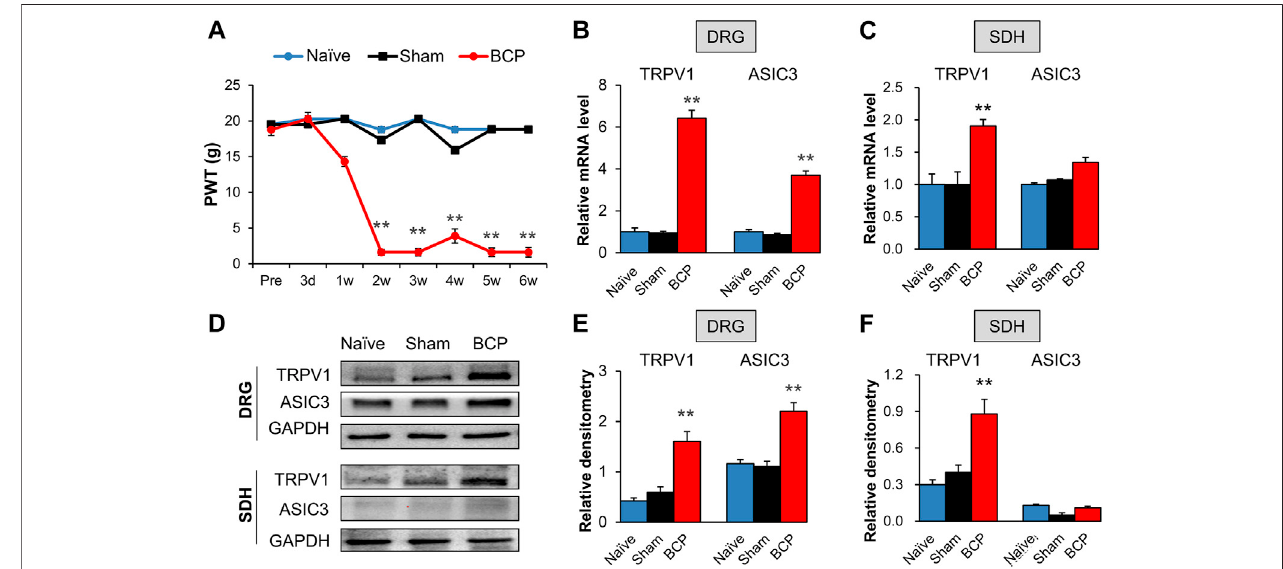
FIGURE1 | The expression of TRPV1 and ASIC3 wasincreased in BCPrats. (A) PWT was signi fi cantly reduced 2 weeks after tumor cell compared with the Naïve group (SD healthy female rats with not any treatment) and Sham group (normal saline injection) (** p < 0.01 vs. Sham, two-way repeated measures ANOVA followed by Tukey ’ s post hoc test). (B) Quanti fi cation of QPCR assays showing signi fi cant up-regulation of TRPV1 and ASIC3 mRNA expression in L4-6 DRGs of BCP rats at 2 weeks after transplantation compared with Sham rats (** p < 0.01 vs. Sham, two-way repeated measures ANOVA followed by Tukey ’ s post hoc test). (C) Quanti fi cation of QPCR assays showing signi fi cant up-regulation of TRPV1 mRNA expression in L4-6 spinal dorsal horn (SDH) of BCP rats at 2 weeks after transplantation compared with Sham rats (** p < 0.01 vs. Sham, two-way repeated measures ANOVA followed by Tukey ’ s post hoc test). While mRNA expression of ASIC3 in L4-6 spinal dorsal horn (SDH) of BCP rats at 2 weeks after transplantation was not altered compared with Sham rats ( p > 0.05 vs. Sham, two-way repeated measuresANOVAfollowedbyTukey ’ sposthoctest). (D) ImmunoblotshowedtheproteinlevelofTRPV1andASIC3inDRGsandSDHofNaïve,ShamandBCPrats. (E) The protein expression of TRPV1 and ASIC3 in the ipsilateral L4-6 DRGs of BCP rats was signi fi cantly increased compared with Sham rats at 2 weeks after transplantation(** p < 0.01vs.Sham,two-wayrepeatedmeasuresANOVAfollowedbyTukey ’ sposthoctest). (F) ProteinexpressionofTRPV1intheipsilateralL4-6SDH ofBCPratswassigni fi cantlyincreasedcomparedwithShamratsat2 weeksaftertransplantation(** p < 0.01vs.Sham,two-wayrepeatedmeasuresANOVAfollowedby Tukey ’ s post hoc test). While protein ASIC3 expression was not altered. ( p > 0.05 vs. Sham, two-way repeated measures ANOVA followed by Tukey ’ s post hoc test).